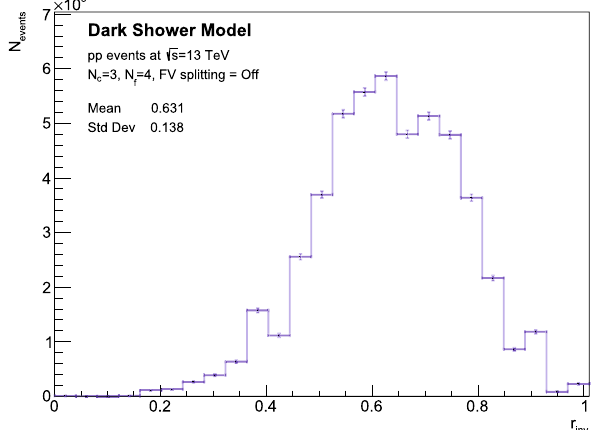
Fig. 25 PdgID distributions for final-state dark particles without the 4900 prefix for a N f off to simulate as the standard pythia 8 version. The parameter probVec = 0 . 75 for both models